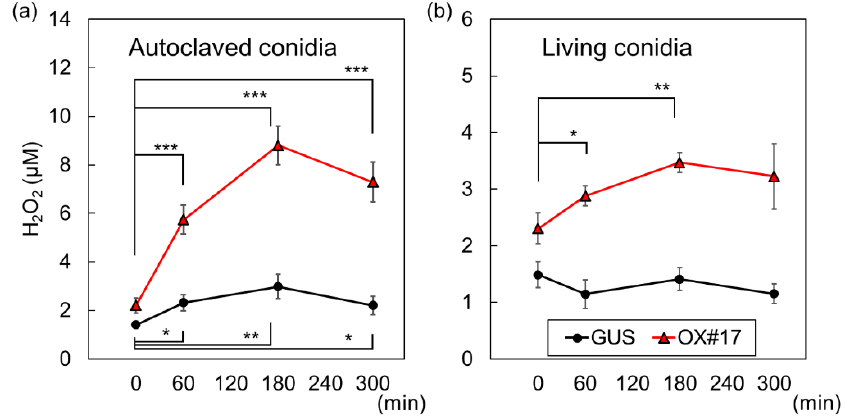
Figure 5. Rice leaf strips derived from BSR1-HPB:OX plants caused an enhanced burst of H 2 O 2 when exposed to conidia of the compatible blast fungus. Leaf strips were cultivated with 8 × 10 4 mL − 1 autoclaved conidia ( a ) or 8 × 10 3 mL − 1 living conidia ( b ) in wells of a 12-well plate. H 2 O 2 concentrations in wells were measured before treatment and at 60, 180, and 300 min after treatment. Values are presented as the means ± standard deviations of three biological replicates. Asterisks indicate significant differences between the untreated condition (0 min) values and the values at the indicated times in the same line (Student’s t -test; * p < 0.05, ** p < 0.01, and *** p < 0.001). Experiments were conducted twice with similar results. OX, overexpressing line; HPB, HA–PreScission–Biotin; OX#17, BSR1-HPB:OX#17; GUS, GUS-HPB:OX.